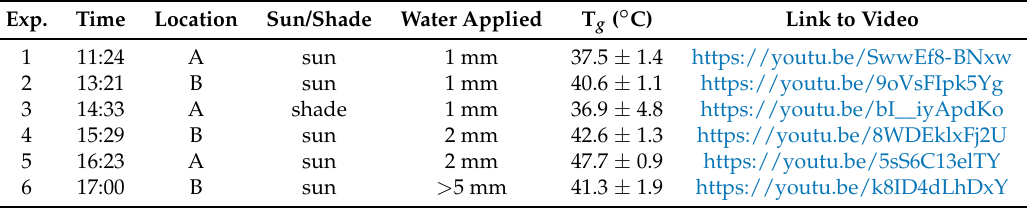
Table 1. Details of the six experiments, with starting time, location, sun or shaded, water applied, surface temperature before water application (T g ), and links to videos showing the vertical evolution of temperature during each